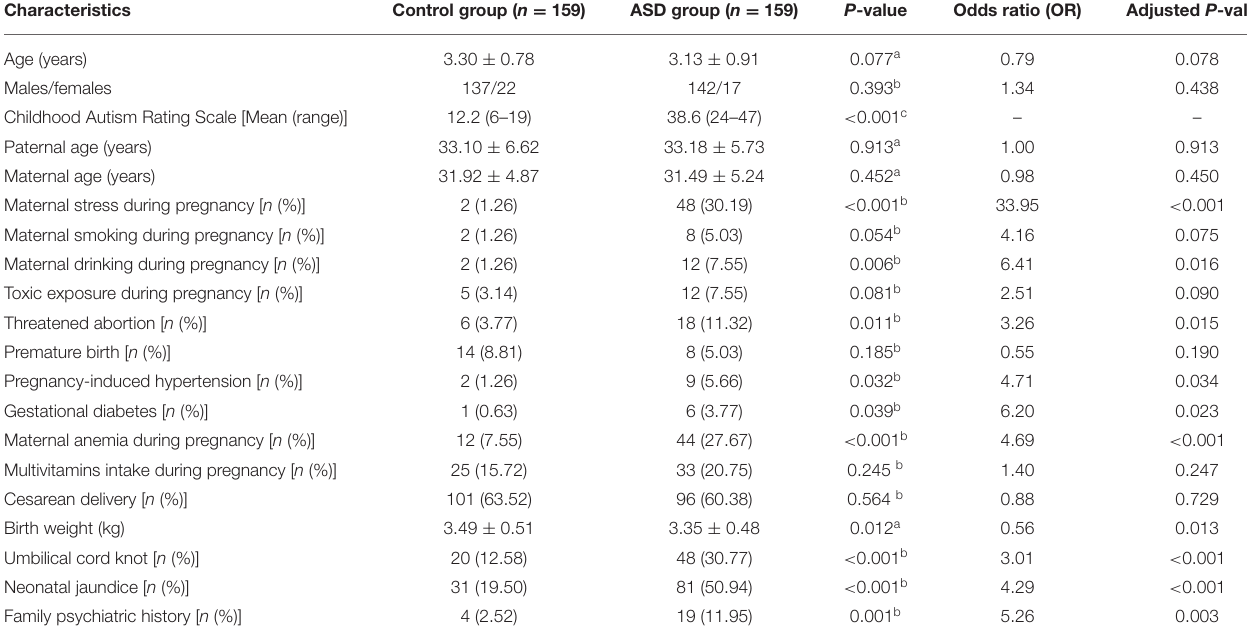
TABLE 1 | Comparison of demographic characteristics between ASD children and healthy controls.